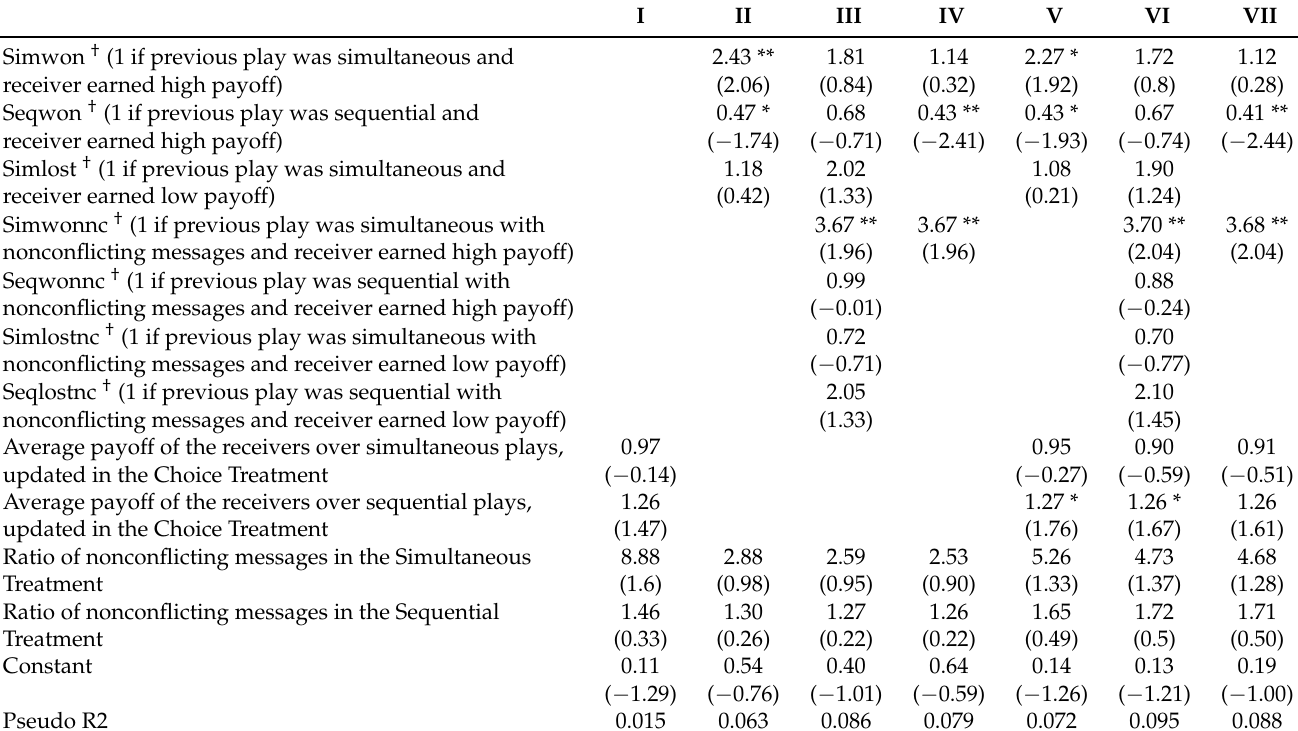
Table 8. Logistic Analysis of Simultaneous